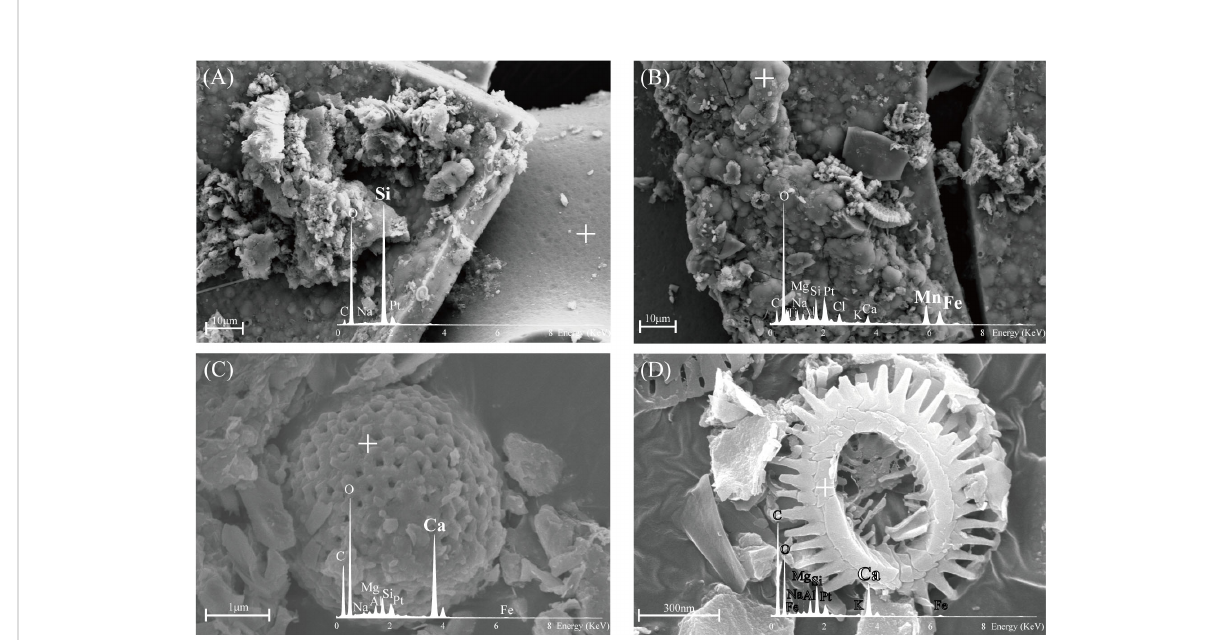
FIGURE 6 Representative SEM secondary electron images and EDS pro fi les of FMP: (A) Smooth surface with high concentration of Si; (B) Globular-like morphology and presence of Mn and Fe; and (C, D) Morphology and EDS pro fi les indicate foraminifera and coccolith, respectively (the crosses indicate the EDS